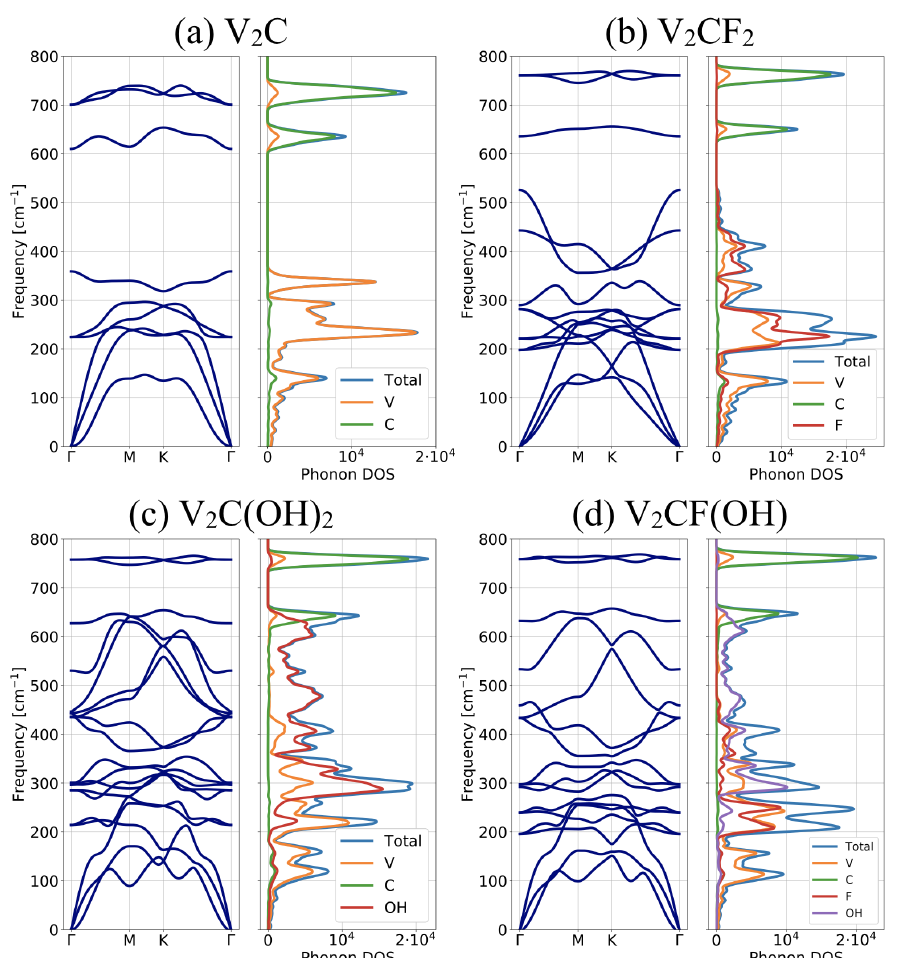
Figure 9. Phonon spectra and projected density of states of ( a ) pristine V 2 C, and terminated ( b ) V 2 CF 2 , ( c ) V 2 C(OH) 2 , ( d ) V 2